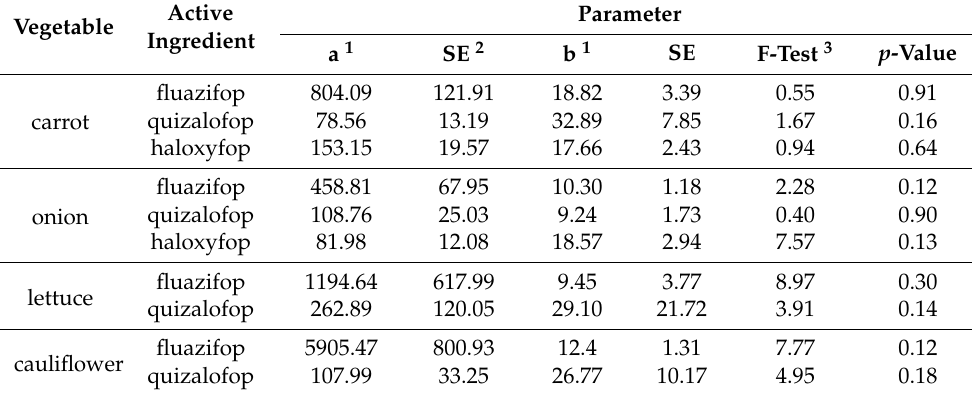
Table 6. Parameters of the exponential decay model and analytical